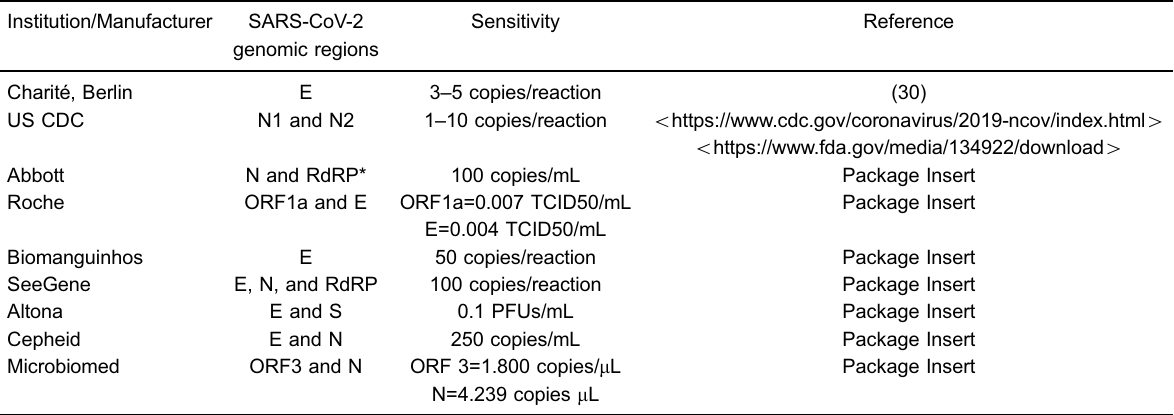
Table 1. Genomic regions targeted by different RT-PCR systems for SARS-Cov-2 and their reported analytical sensitivity.